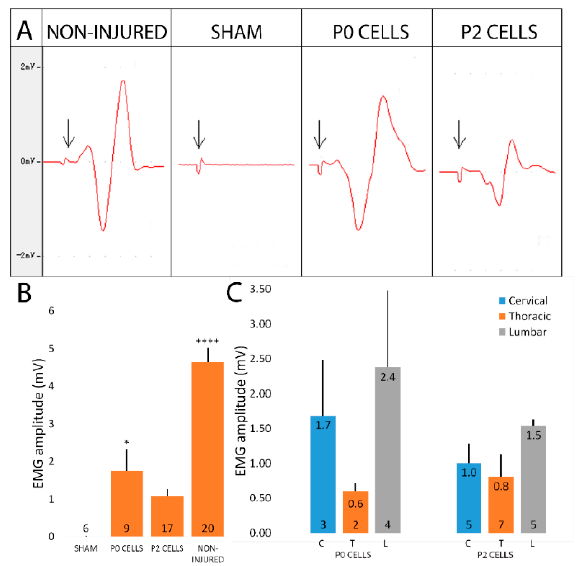
Figure 7. Neuromuscular junctions in cell-grafted animals were functional 12 weeks after the injury and cell transplantation. ( A ) EMG response curves and forelimb movement were similar to the non-injured side in cell-grafted groups while no EMG response and functional improvement was seen in the sham group. The arrow indicates the stimulation artifact; ( B ) P0 cell grafted animals showed higher average EMG amplitude compared to the P2 cell grafted group that were both lower than response amplitude in the non-injured side showing the incomplete reinnervation. As expected, no response was detected from sham animals. Statistical difference is shown versus Sham. Data is expressed as mean + SEM.